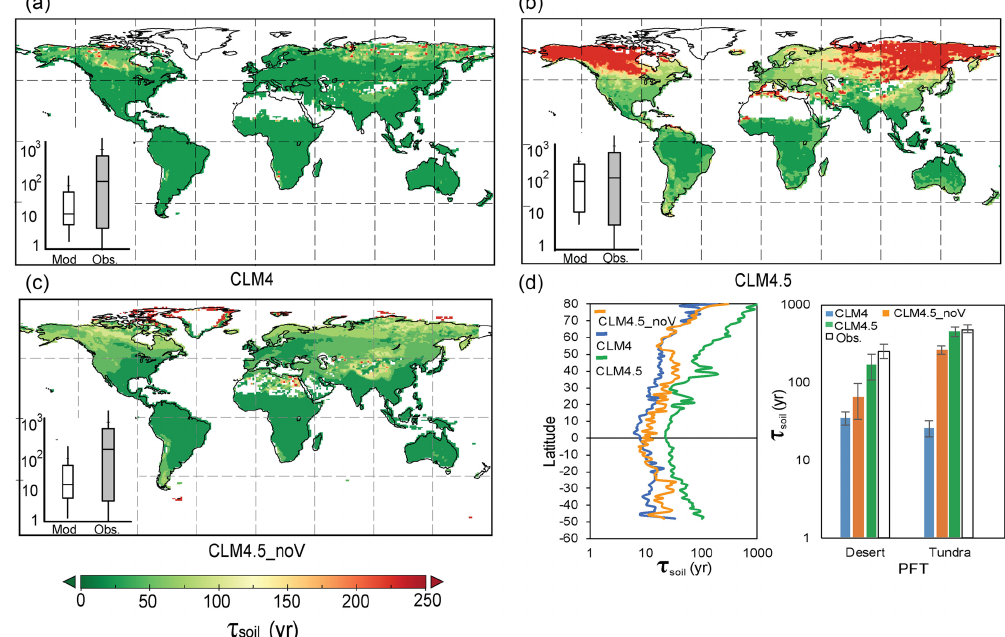
Figure 5. Simulated SOC transit time ( τ soil ) by CLM4 ( a , median global τ soil = 20 . 56 years), CLM4.5 ( b , median global τ soil = 127 . 50 years), and CLM4.5_noV ( c , median global τ soil = 22 . 24 years). Panel (d) shows the latitudinal spatial distribution of the mean τ soil of different models in desert and tundra. The inserts in (a) – (c) compare the τ soil between models and observations. The bottom and top of the box represent the first and third